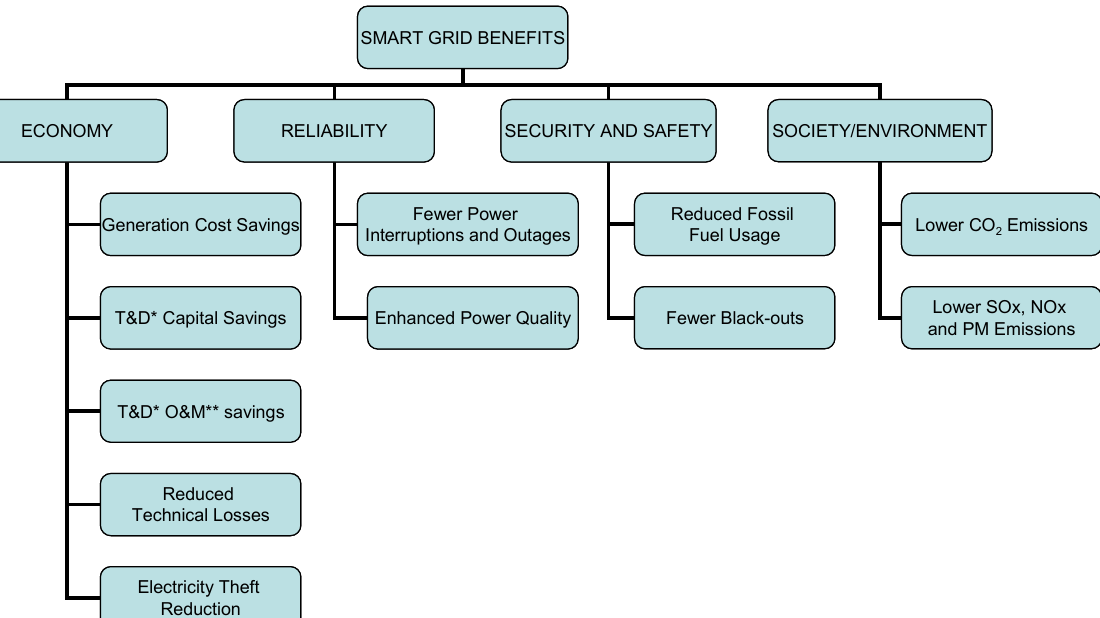
Figure 2. Classification of smart grid benefits with regard to the target sectors involved.